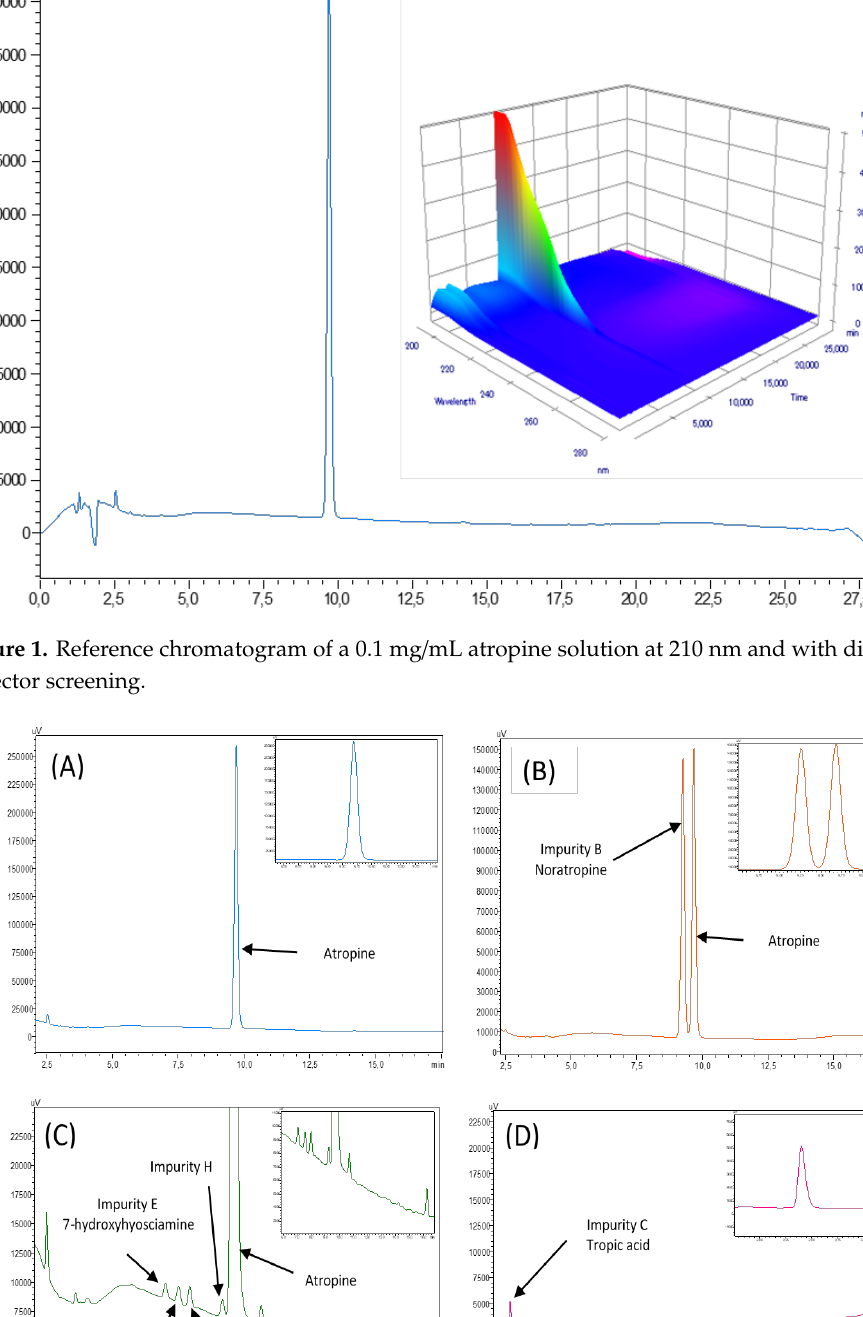
Figure 2. Chromatograms of atropine impurities at 210 nm: ( A ) reference atropine chromatogram, ( B ) chromatogram of the atropine impurity B CRS solution, ( C ) chromatogram of atropine for the peak identification CRS (containing impurities A, D, E, F, G, and H) solution, and ( D ) chromatogram of the tropic acid R (impurity C) solution. The insets represent a close up of the